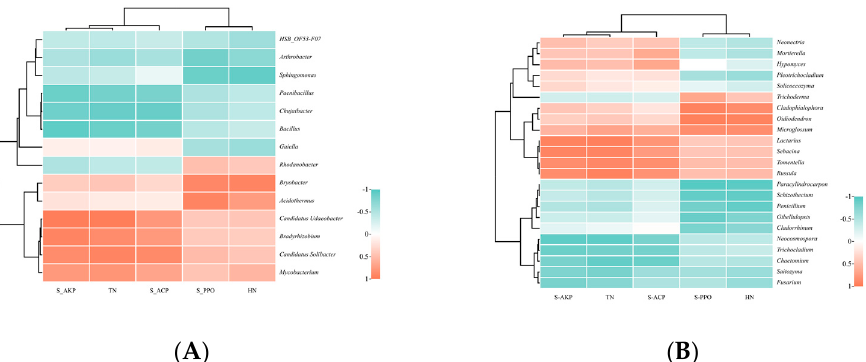
Figure 12. ( A ) Heatmap of bacterial communities at the genus level with soil physicochemical properties and enzyme activities. ( B ) Heatmap of fungal communities at the genus level with soil physicochemical properties and enzyme activities. CH—biennial ginseng seedlings that were transplanted and then continuously cropped for four years in healthy ginseng rhizosphere woodland soil, CD—biennial ginseng seedlings that were transplanted and then continuously cropped for four years with severe soilborne disease in ginseng rhizosphere woodland soil, CK—soil sample from woodland without ginseng planting. TN—total nitrogen, HN— hydrolyzable nitrogen, S-ACP—soil acid phosphatase activity, S-AKP—soil alkaline phosphatase activity, and S-PPO—soil polyphenol oxidase activity.